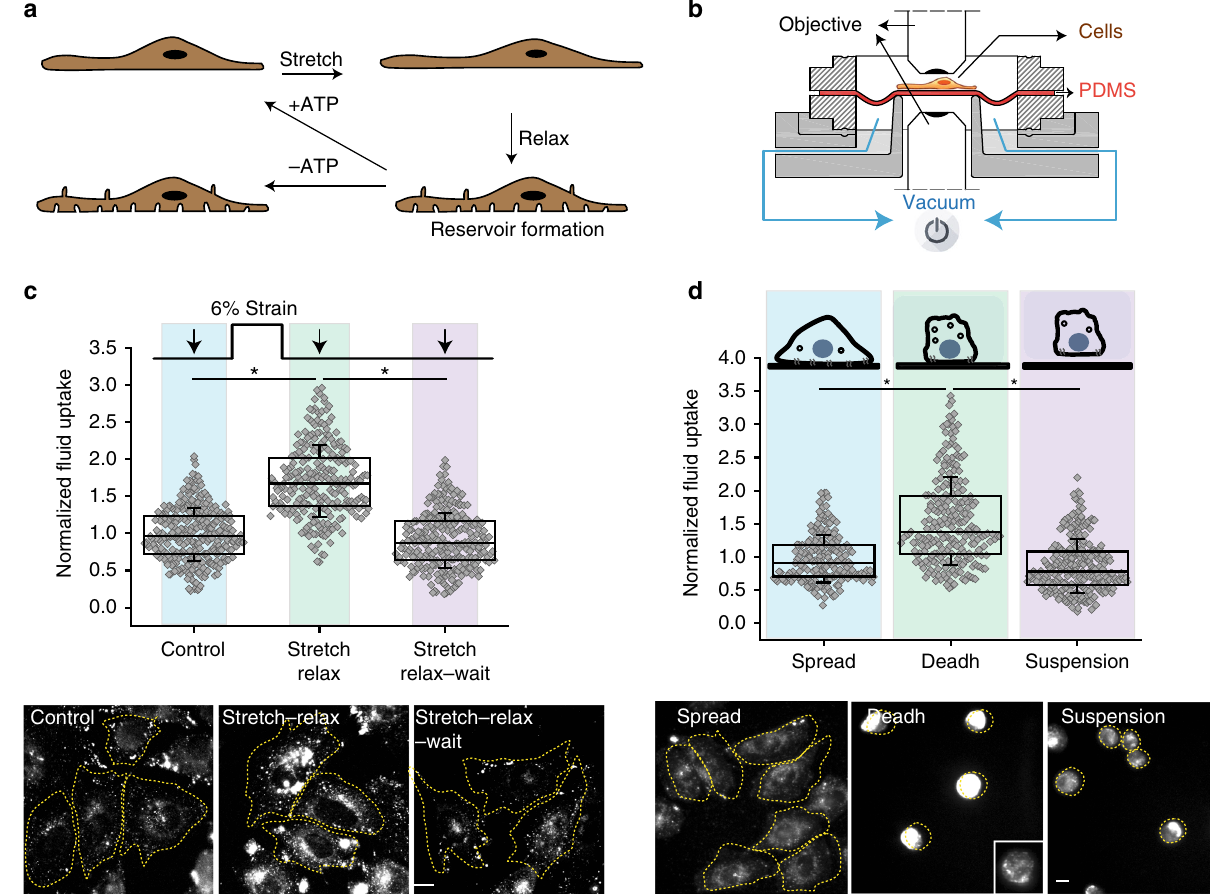
Fig. 1 A fast transient endocytic response to decrease in membrane tension. a Cartoon showing membrane remodeling responses after mechanical strain. Cells after the stretch and relax protocol form invaginations termed ‘ reservoirs ’ 6 . These reservoirs are resorbed in a few minutes by an active process and requires ATP. b The illustration shows the longitudinal section of a vacuum-based equi-bi-axial stretching device. Cells plated on a PDMS sheet are stretched by the application of controlled vacuum below the circular PDMS sheet, which stretches it in a calibrated manner. Releasing the vacuum relaxes the strain on PDMS thus relaxing the cell. Cells plated on PDMS can be imaged in an upright or inverted microscope as required. c Fluid uptake (90 s) in CHO cells at steady state (steady state), immediately on relaxing the stretch (stretch – relax), or after a waiting time of 90 s on relaxing the stretch (stretch – relax – wait) ( n = control (316), stretch – relax (257), stretch – relax – wait (277)). d Fluid uptake in CHO cells for 3 min in adhered cells (Spread), during de-adhering (Deadh), or immediately after cells are detached and in suspension (Suspension). Images and box plot show the extent of fl uid-phase uptake under the indicated conditions ( n = spread (196), deadh (241), suspension (274)). Box plot shows median, 25th and 75th percentile, and whiskers show the standard deviation. Individual data points are overlaid on box plot where each data point is the mean intensity per cell. The ‘ n ’ indicates total number of cells in each condition pooled from two different experiments with duplicates per experiment; * p < 0.001, ns not signi fi cant by Mann – Whitney U test. Scale bar, 10 µ